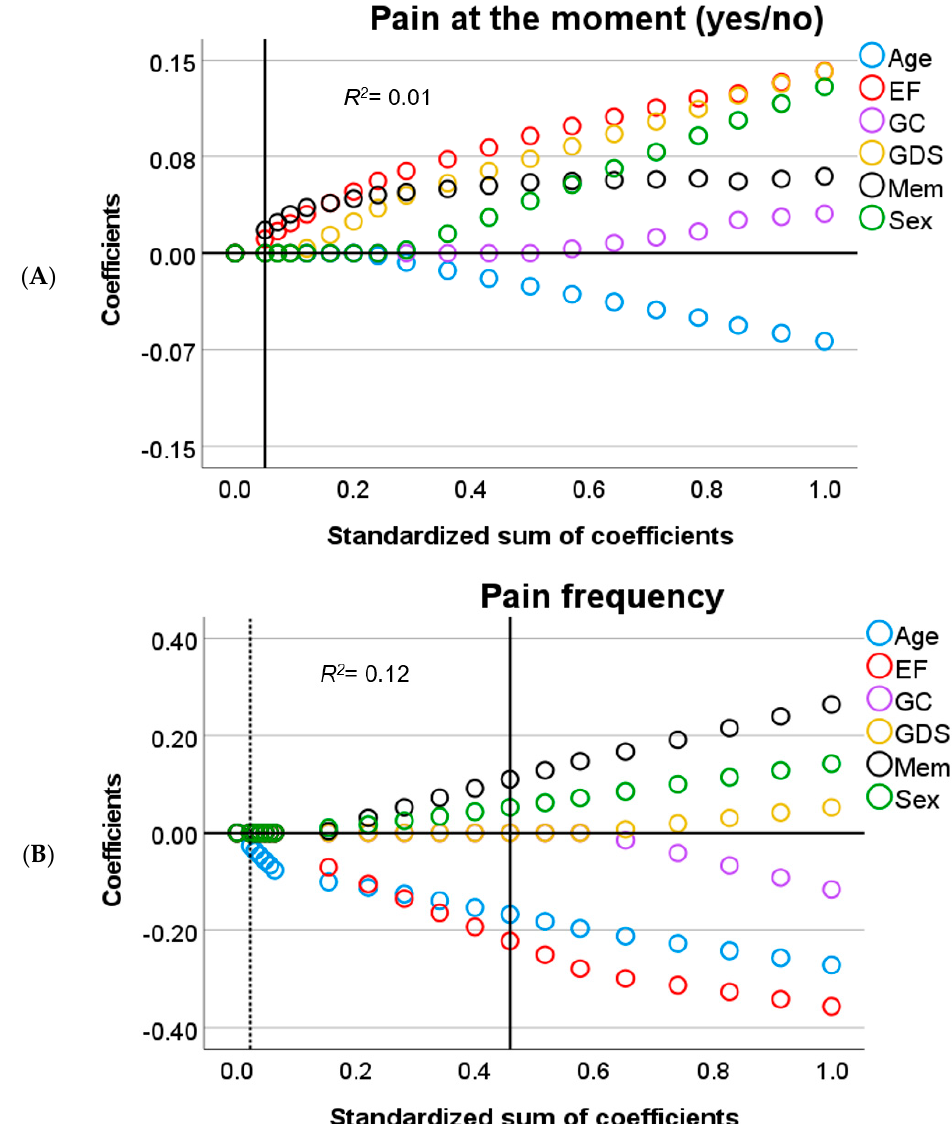
Figure 1. Output charts Lasso regression (Model 1). Input predictors are displayed in alphabetical order but were introduced as follows: sex, age, Geriatric Depression Scale score (GDS), executive function (EF), global cognition (GC), and memory (Mem). Identified predictors and the respective dependent variables are: ( A ) EF and Mem as predictors of the occurrence of pain; and ( B ) sex, age, EF, and Mem as predictors of pain frequency. Lasso coefficients (colored rings) represent positively and negatively related predictors above and below zero, respectively (y–axis). Vertical lines intersect the coefficients ( ≠ 0) from the most parsimonious predictors (dotted line) and the optimal predictors (solid line) as computed in the different models (these lines might coincide). In each subfigure, the values of the x–axis represent the relative influence of all the parameters over the dependent variable before shrinkage (standardized sum of coefficients = 1.0 minus shrinkage = 0, which is equal to 1.0 on the right side). At each stage of shrinkage (increasing from right to left in the x–axis), a higher penalty is added until the standardized sum of coefficients is at its lowest (i.e., 0) and shrinkage is at its highest (i.e., 1.0). The smallest prediction error is represented by the solid line tangential to the corresponding shrinkage stage. The predictors with still meaningful associations ( ≠ 0) at such a stage are considered optimal predictors with Lasso coefficients marked in the y–axis. Regularization-R 2 is displayed on the top-left corner of each of the plots.